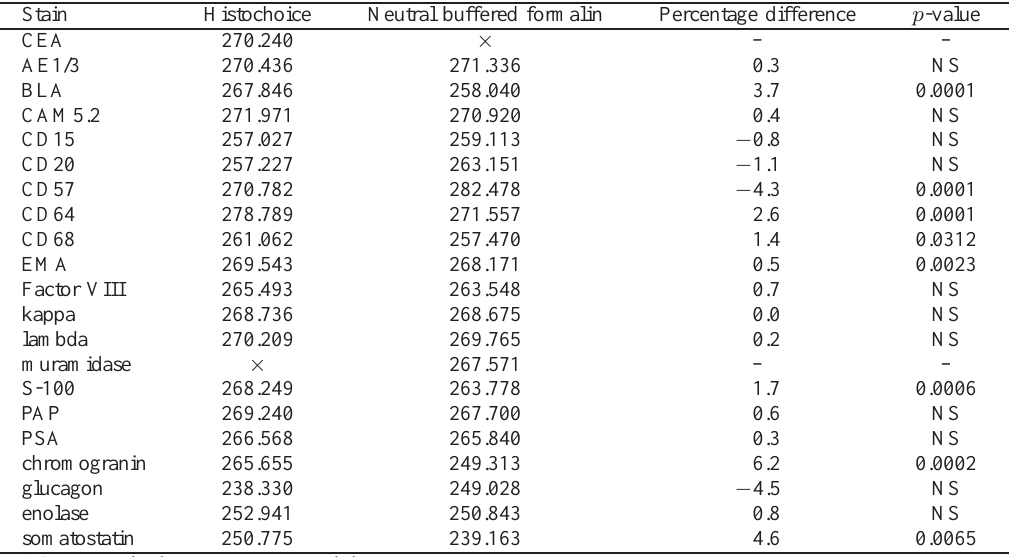
Table 2 Quantitative analysis of hue for histochoice and formalin fixed tissue